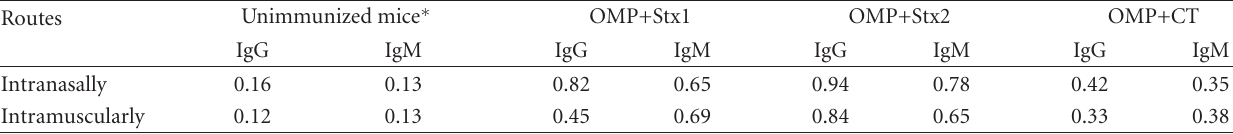
Table 2: Avidity index of IgG and IgM antibodies of immunized mice by intranasally and intramuscularly routes.